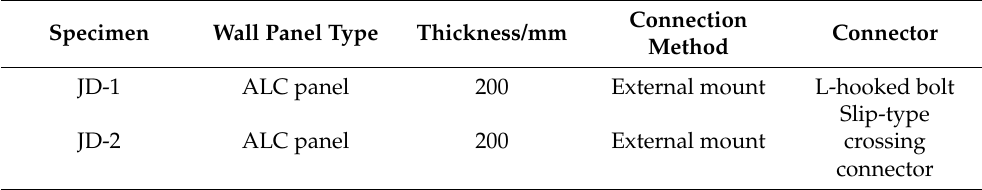
Figure 2. Details of the experimental design. ( a ) Geometric dimension of the flat combination frame; ( b ) geometric dimension of the slip-type crossing connector. Table 2. Parameters of the specimen. Table 2. Parameters of the specimen.